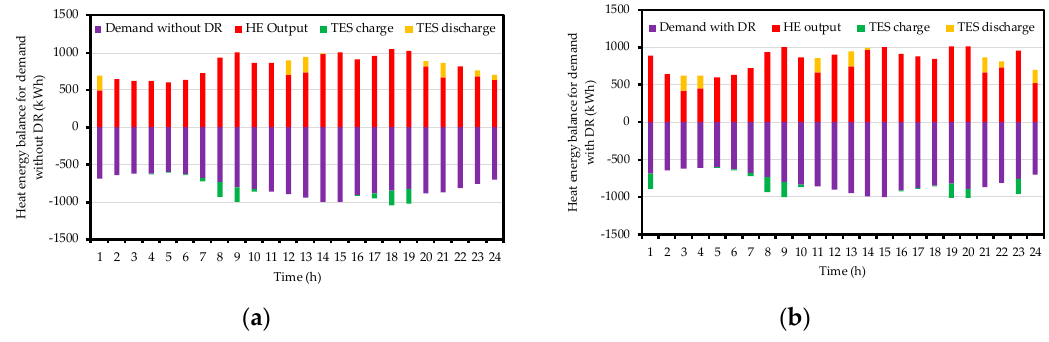
Figure 10. Optimal scheduling results for heat: ( a ) without DR; ( b ) with DR.